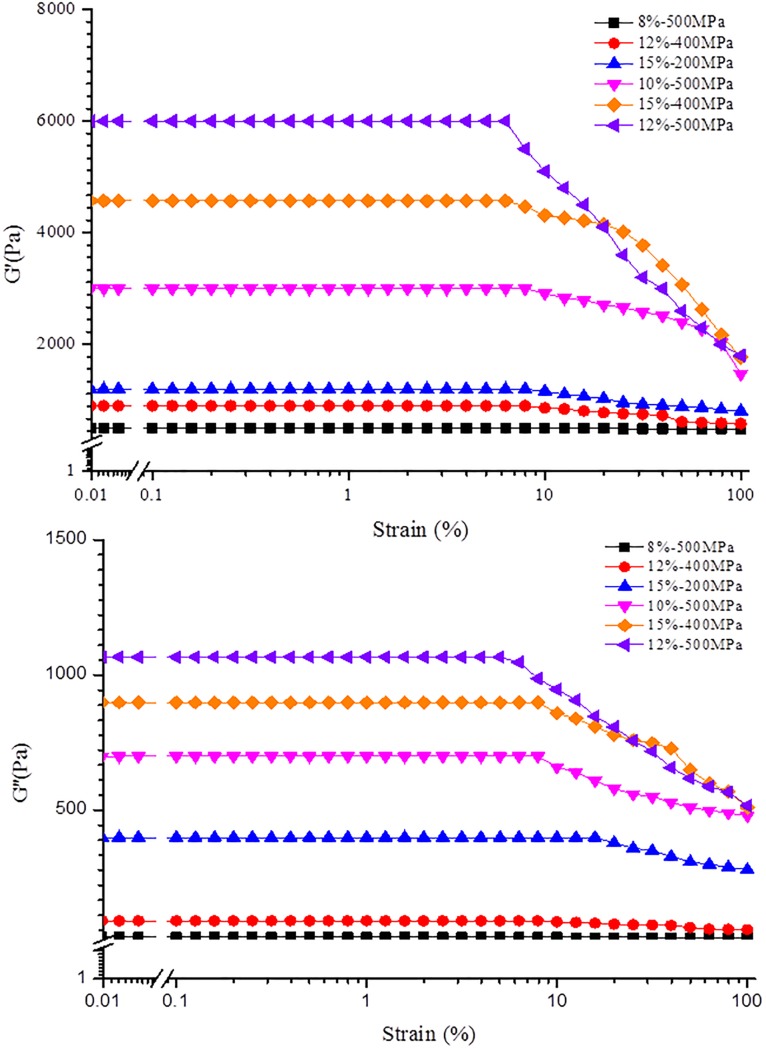
The strain sweep curves (G′ and G″) of β-glucan (OG) prepared with different concentrations at different pressures.